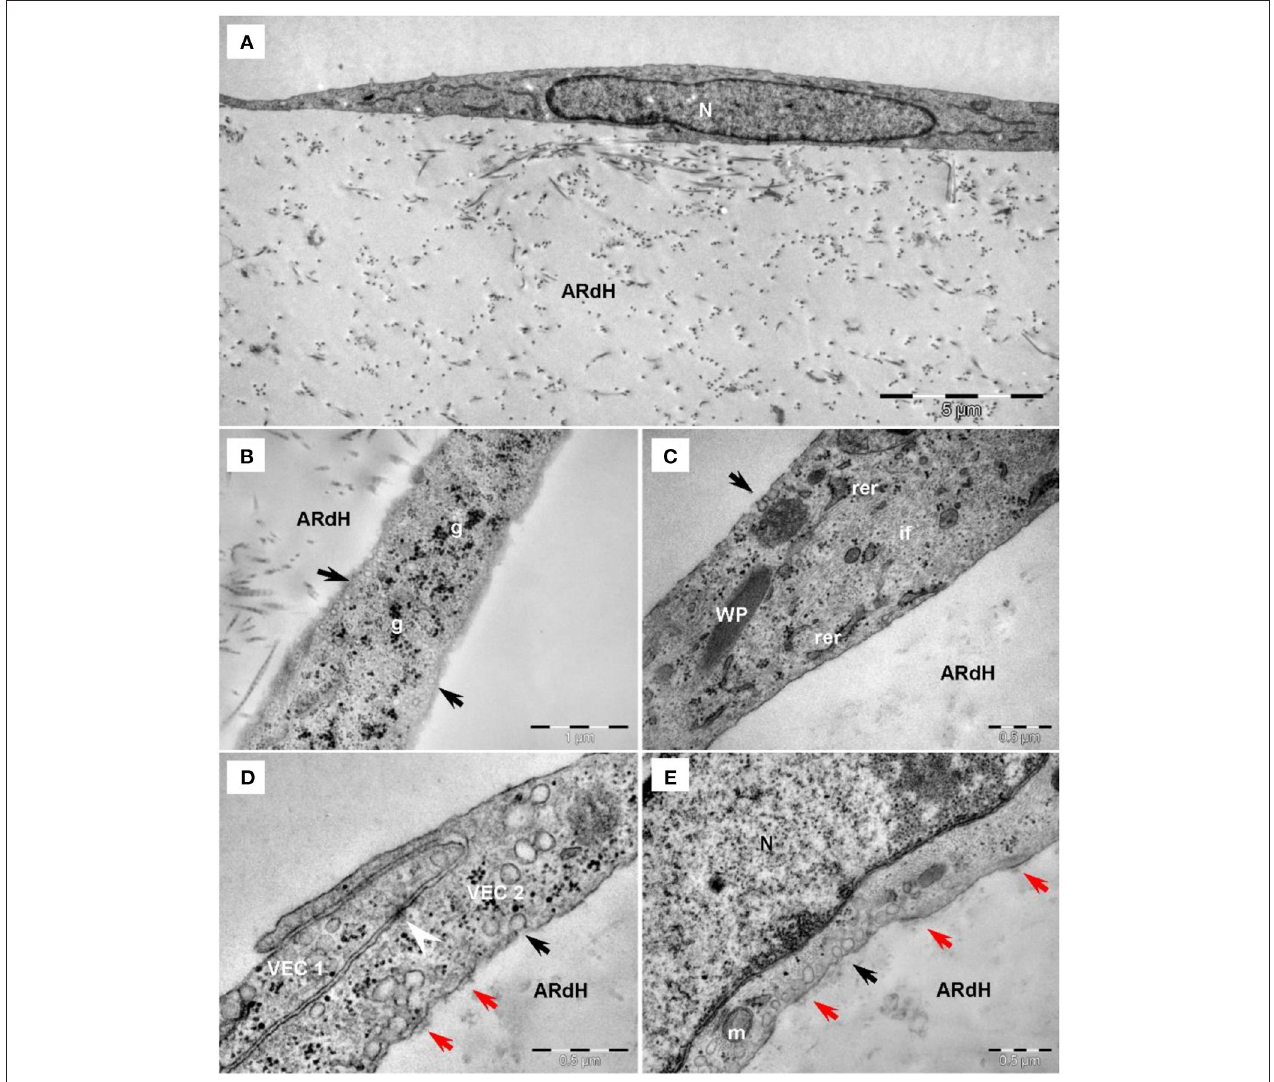
FIGURE 3 | Transmission electron microscopy of VEC exposed to normal glucose conditions on the hydrogel construct (ARdH). (A) VEC show a central euchromatic nucleus (N) and long, flat cellular extensions, a few endoplasmic reticulum cisterna and mitochondria. ARdH contains fibrillary collagen. (B) Numerous caveolae are visible on the cellular membrane and in the cortical space (black arrows). Glycogen particles (g) are spread throughout the cytoplasm. (C) Intermediate filaments (if) are well-represented. Weibel-Palade bodies (WP) are present in VEC. Rough endoplasmic reticulum (rer) showed few cisternae. (D) Intercellular connections between VEC1 and VEC2, recessus adhaerens type (or plug and socket), are fastened by adhaerens junction (arrowhead). Focal adhesion points (red arrows) connect VEC to the support construct. (E) Focal adhesion points (red arrows) connect the VEC to the hydrogel construct (AR). Black arrows indicate caveolae. m, mitochondrion; N,